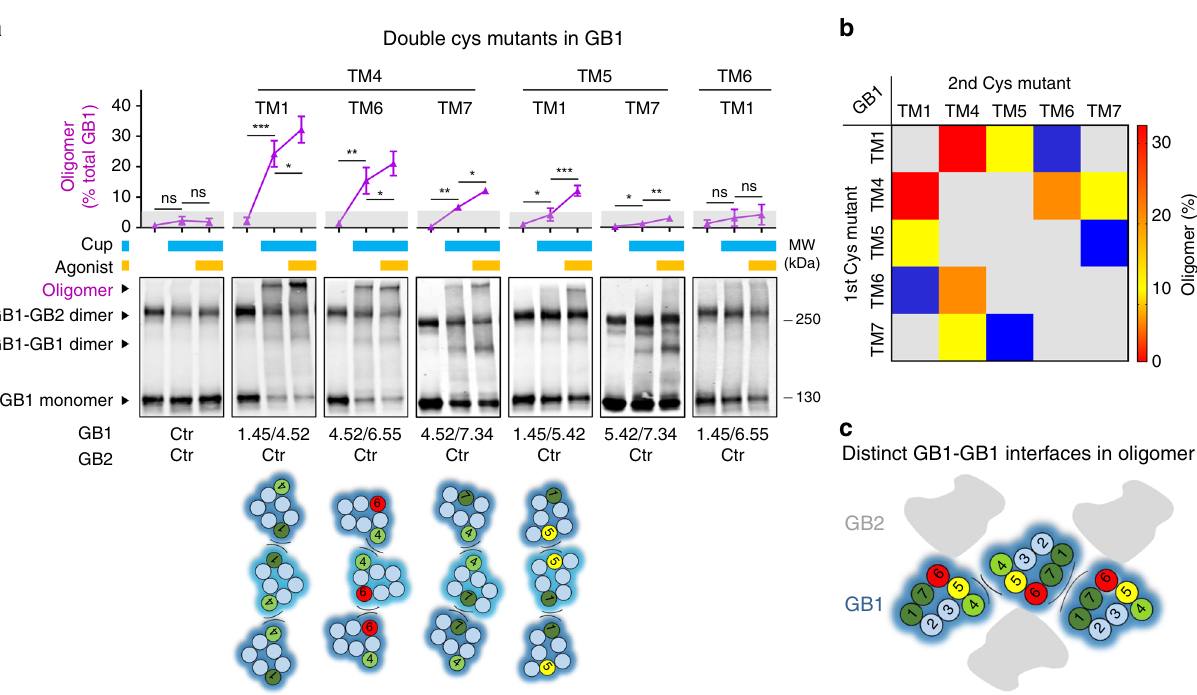
Fig. 7 High-molecular-weight complexes con fi rm the two interfaces between GB1s in oligomers. a Quanti fi cation of the oligomers obtained after cross- linking of the double cysteine substitution in different TMs of the GB1 subunit, after pre-incubation or not with GABA and with CuP, as indicated. The percentage of oligomers (in purple) relative to the total amount of GB1 subunit was quanti fi ed from the fl uorescent blots. The pictograms indicate the possible cross-linking of three GB1 subunits that could form the oligomer band of the corresponding blot. These schemes are from snapshots of the GABA B oligomer 3D model when morphing are performed between the inactive and active states (see Figs. 9a, b). GABA was used at 100 μ M. Data are mean ± SD of at least three individual experiments (n = 3 – 5). Paired t test with Welch ’ s correction with *** P < 0.001, ** P < 0.01 and * P < 0.1, the other data being not signi fi cant (ns). b Quanti fi cation of the oligomers (% of total GB1) obtained for the indicated pairs of cysteines in panel ( a ), after cross-linking in presence of CuP and GABA. c Model of the 7TM of GABA B oligomers highlighting the two distinct and possible interfaces between the GB1 subunits during